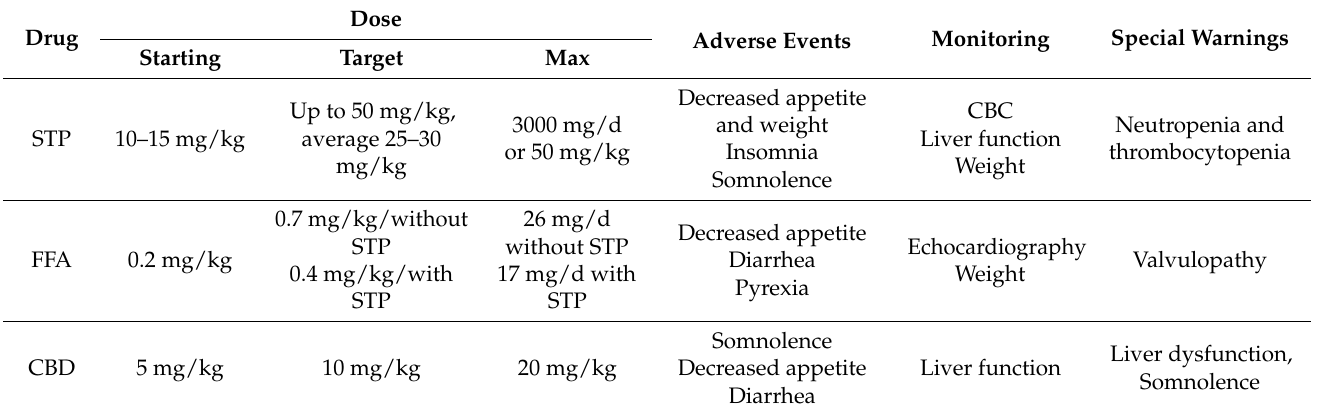
Table 1. Dosing and therapeutic characteristics of new drugs approved in